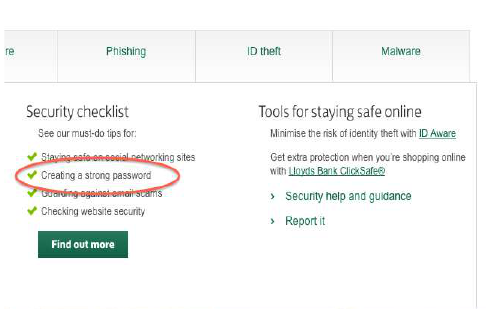
Figure 5-1: Strong Password.